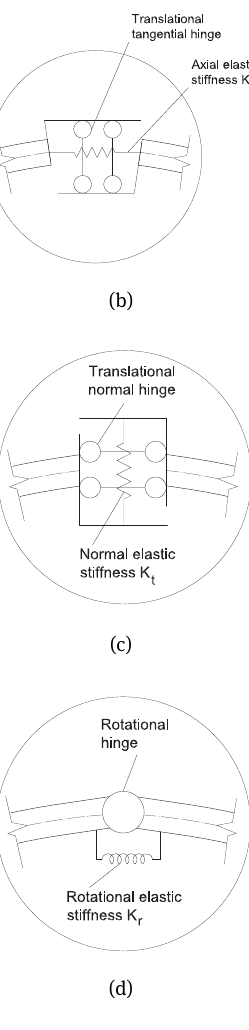
Figure 5: (a) Parabolic arch with a notch in the key section. The notch is modelled as: (b) a translational tangential elastic hinge; (c) a translational normal elastic hinge; (d) a rotational elastic